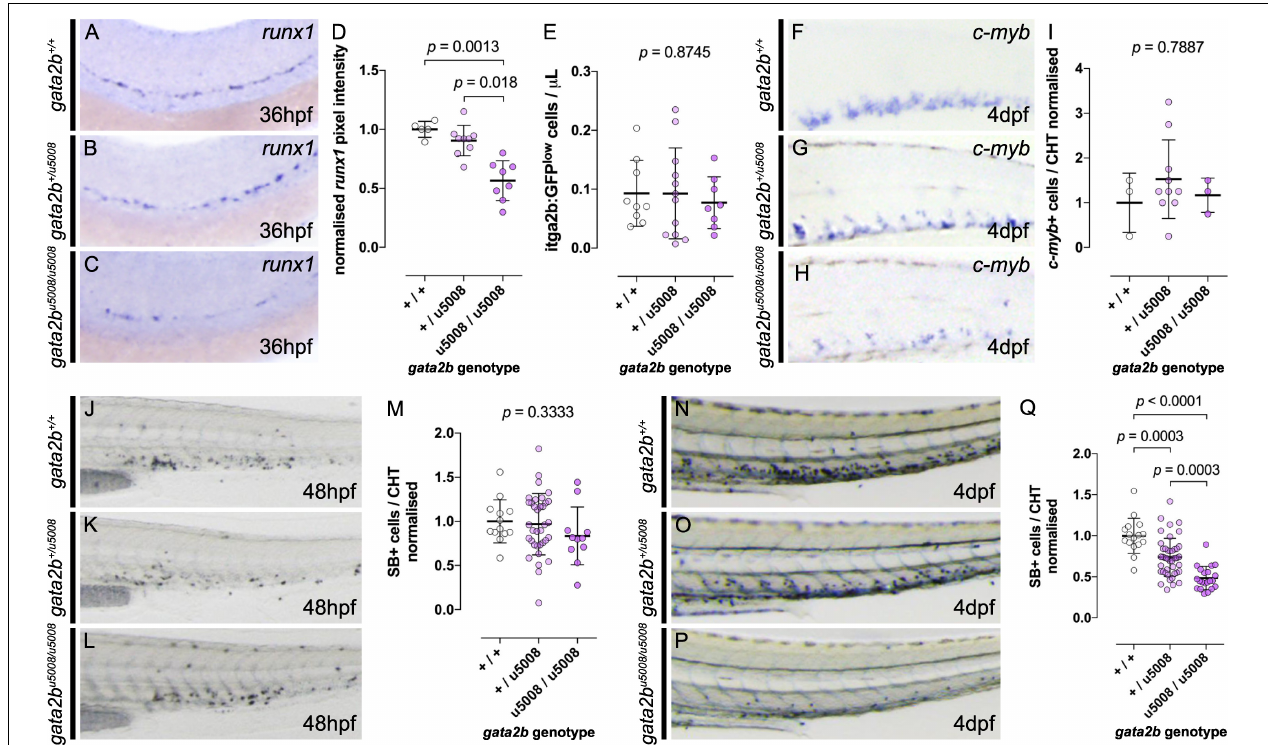
FIGURE 3 | Gata2b is necessary for HSPC specification but dispensable for HSPC maturation. (A–C) Analysis of runx1 expression at 36 hpf by in situ hybridization in Gata2b u 5008 mutant embryos shows decreased expression in gata2b u 5008 / u 5008 homozygotes. (D) Quantification of runx1 expression in the AGM of 36 hpf mutant embryos shows allele dependent decrease of runx1 expression. (E) Number of itga2b:GFP lo cells by flow cytometry of individual Tg(itga2b:GFP) Gata2b u 5008 mutant embryos at 3 dpf. (F–H) Expression of c-myb by in situ hybridization in the CHT of 4 dpf mutant larvae. (I) Quantification of c-myb + cells in the CHT of 4 dpf mutant fish. In (J–L) , lateral views of 48 hpf mutant embryos stained with SB, labeling granulocytes. (M) Quantification of SB+ cells in the CHT of 48 hpf mutant embryos. In (N–P) , SB stainings of 4 dpf larvae show allele dependent decrease of SB+ cells in the CHT of Gata2b u 5008 mutant fish, quantified in (Q)